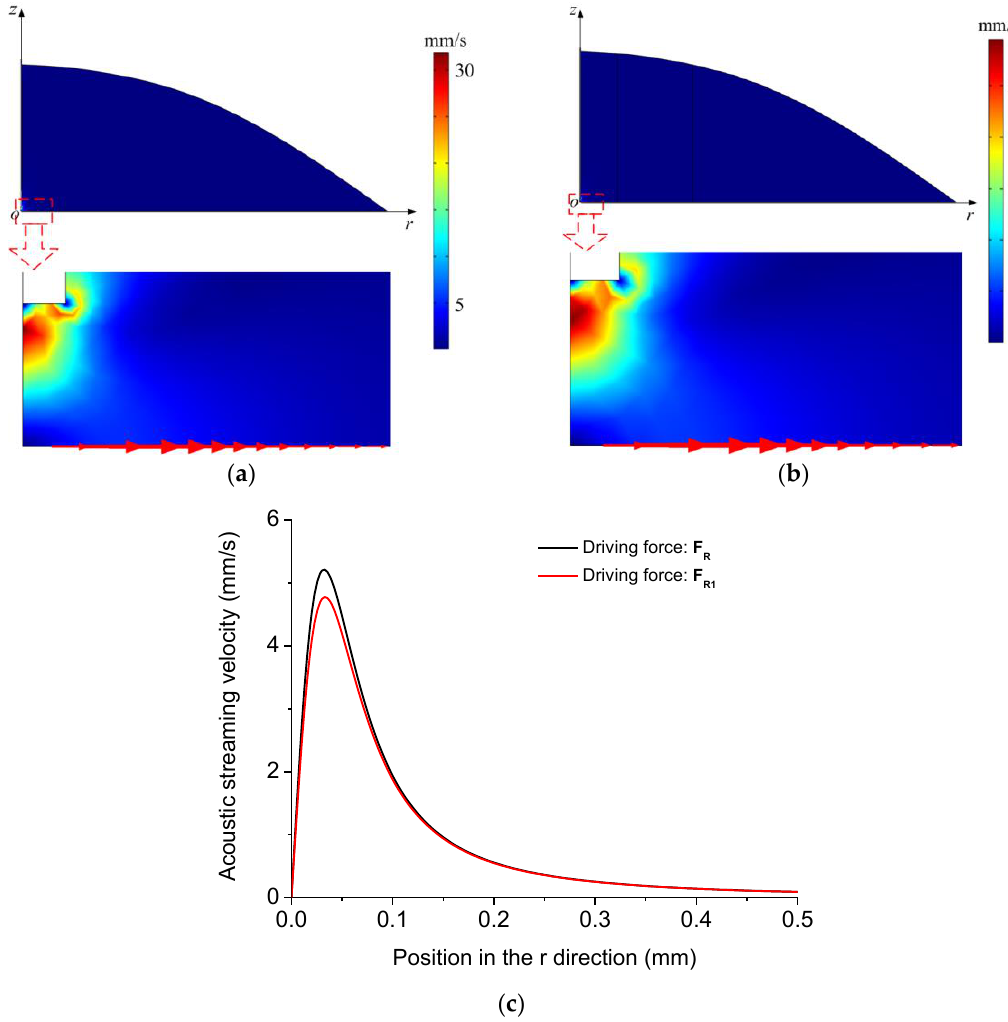
Figure 4. ( a ) Acoustic streaming field in the ultrasonic probe-droplet-substrate system computed by the PM. ( b ) Acoustic streaming field in the ultrasonic probe-droplet-substrate system computed by the RSM. ( c ) Computed acoustic streaming velocity distribution along the r direction at the droplet-substrate interface in the ultrasonic probe-droplet-substrate system when the driving forces of acoustic streaming are F R and F R1 , respectively.